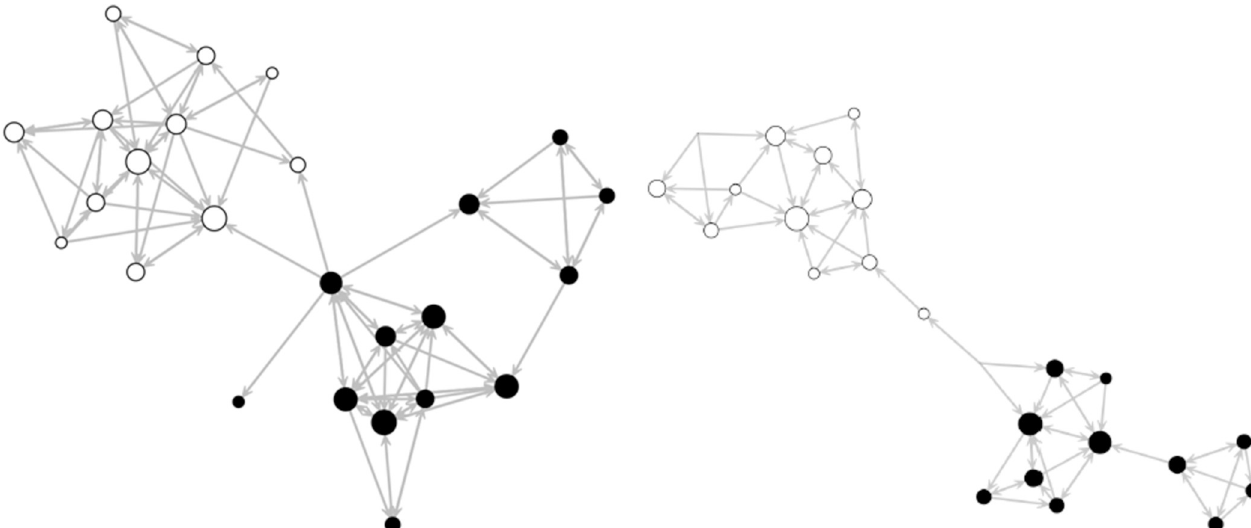
Fig 1. Social networks of close friends and admired peers. Social ties (arrows) are based on directed peer nominations between individuals (nods). The black nods are female, and white nodes are male. Size of the nods reflects indegrees (i.e., received nominations) of individuals.